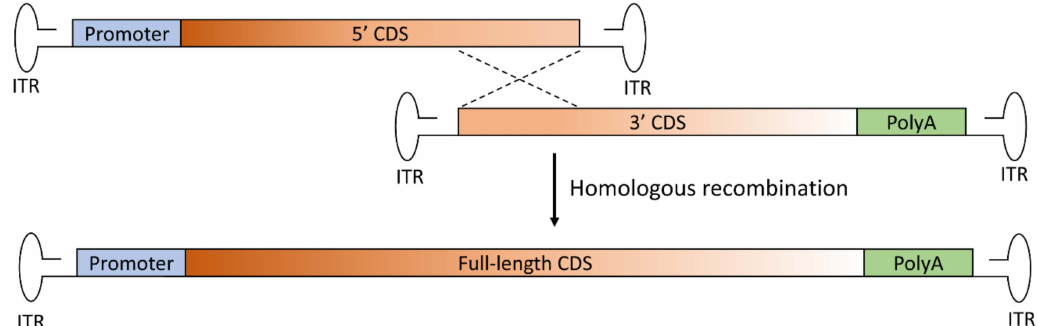
Figure 2. Schematic representation of the overlapping dual AAV approach for large gene reconstitution. The first vector includes the promoter and the 5’-half of the coding sequence (CDS) and the second vector includes the 3’-half of the CDS and the polyadenylation signal (PolyA). A portion of the sequence of the large transgene is repeated in both vectors (at the 3’ end of the CDS of the first vector and at the 5’ end of the CDS of the second vector). Thus, the full-length transgene expression cassette is reconstituted through homologous recombination of the overlapping regions in the two vectors. ITR: inverted terminal